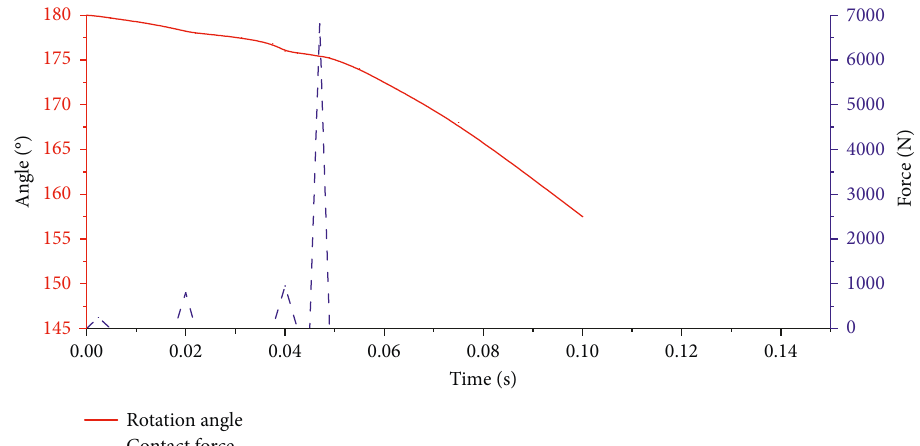
Figure 11: The curve of the complementary angle change of the angle between the axis of the drum tooth disk and the auxiliary line.